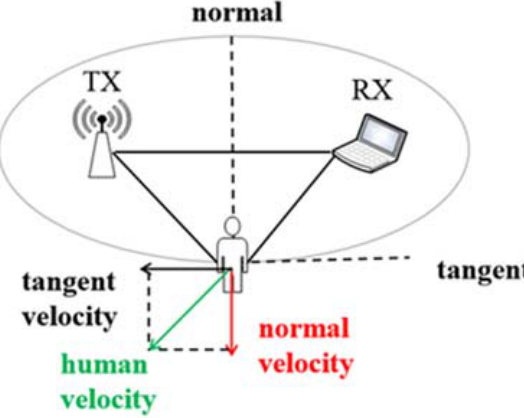
Figure 6. Geometrical relationship between human velocity and Doppler velocity.